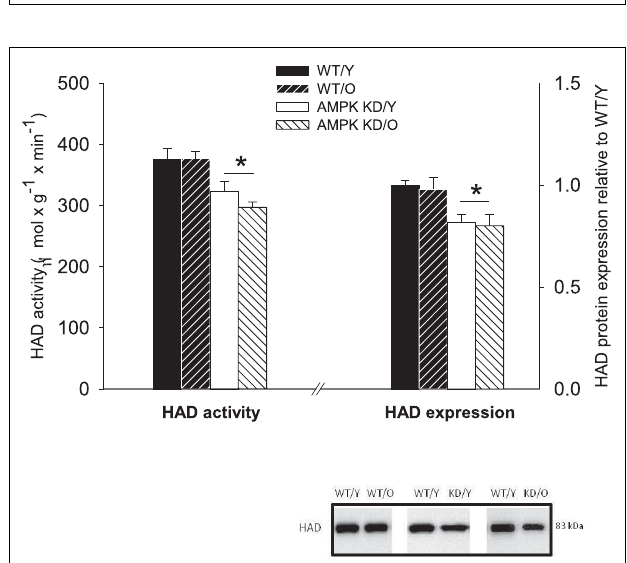
FIGURE 4 | 3-Hydroxyacyl-CoA-dehydrogenase (HAD) enzyme activity (left Y -axis) and protein expression relative toWT/Y (right Y -axis). *Different fromWT/Y ( P < 0.05).